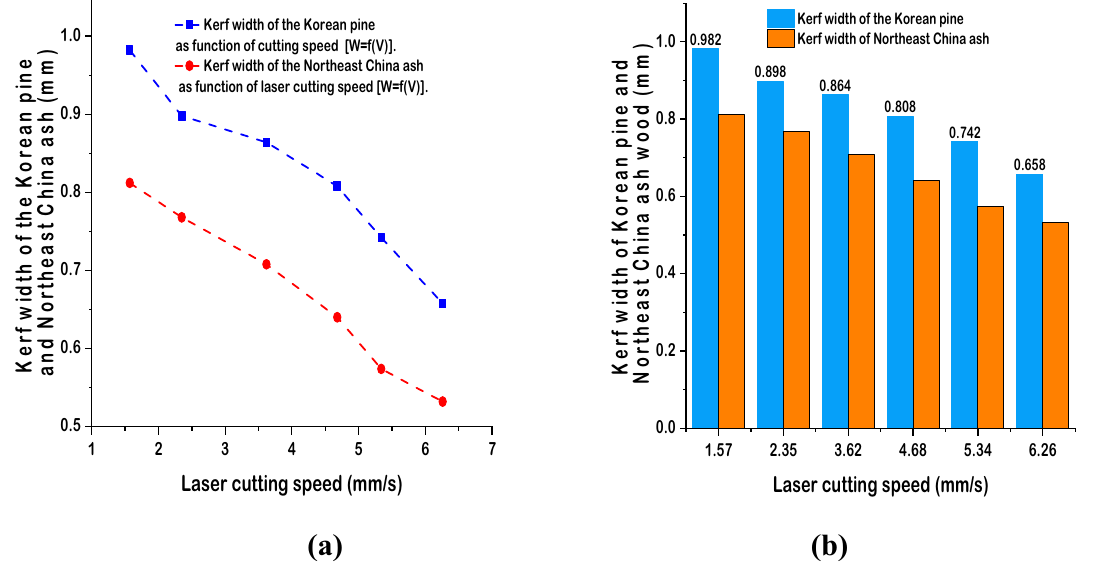
Fig. 16 Joint view of kerf width as a function of laser cutting speed of the two types of wood a Kerf width, b Histogram